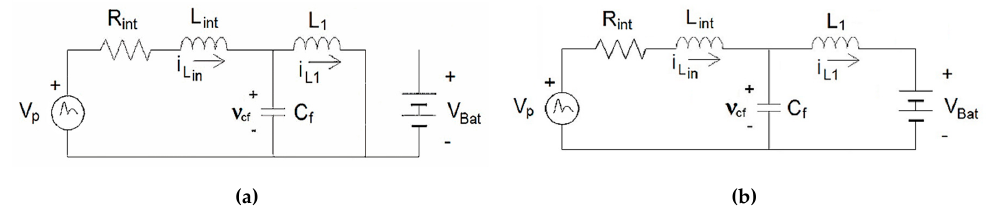
Figure 12. Boost mode, HBB converter topologies: ( a ) ON and ( b ) OFF.